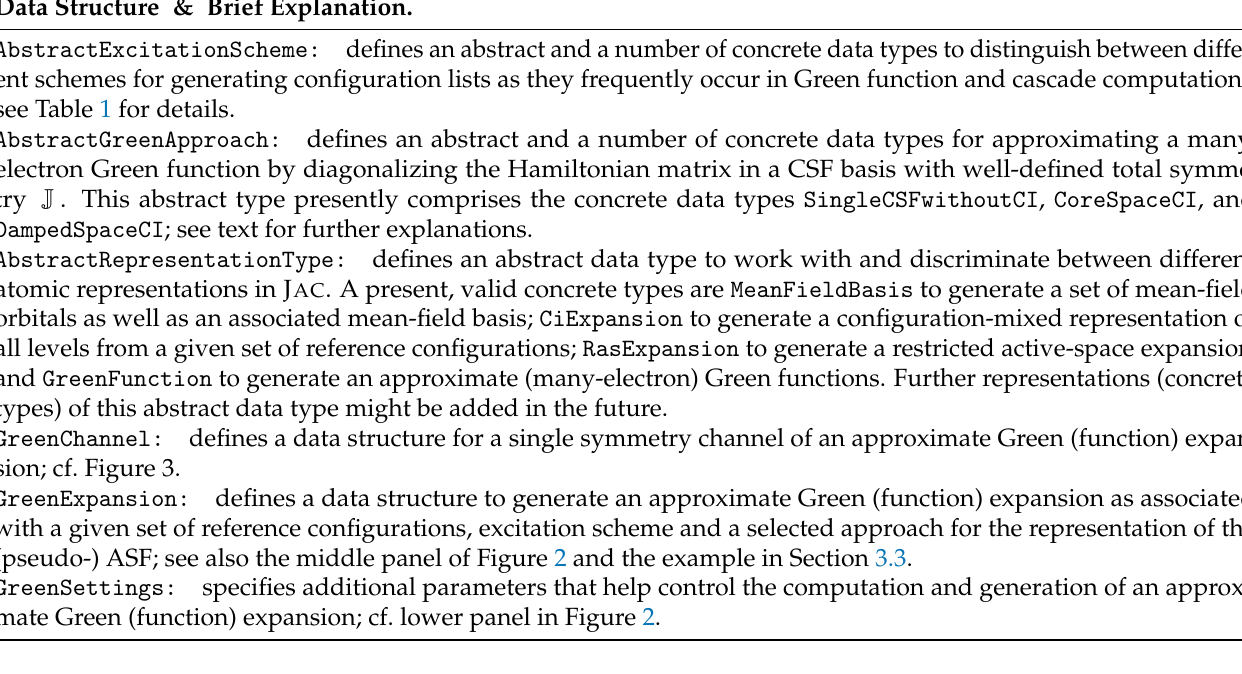
Table 2. Selected data structures of the J AC toolbox that are relevant for the generation of approximate Green functions. Data Structure & Brief